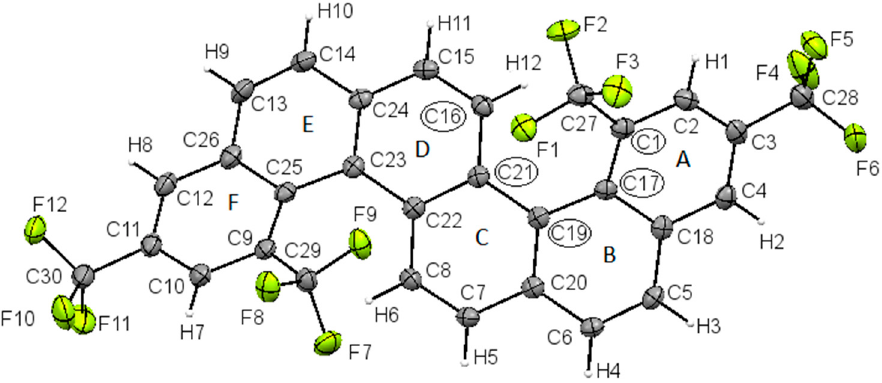
Figure 2. The molecular structure of 4b ; the thermal ellipsoids were drawn on 50% probability level. Pale green ellipsoid represents F atoms.